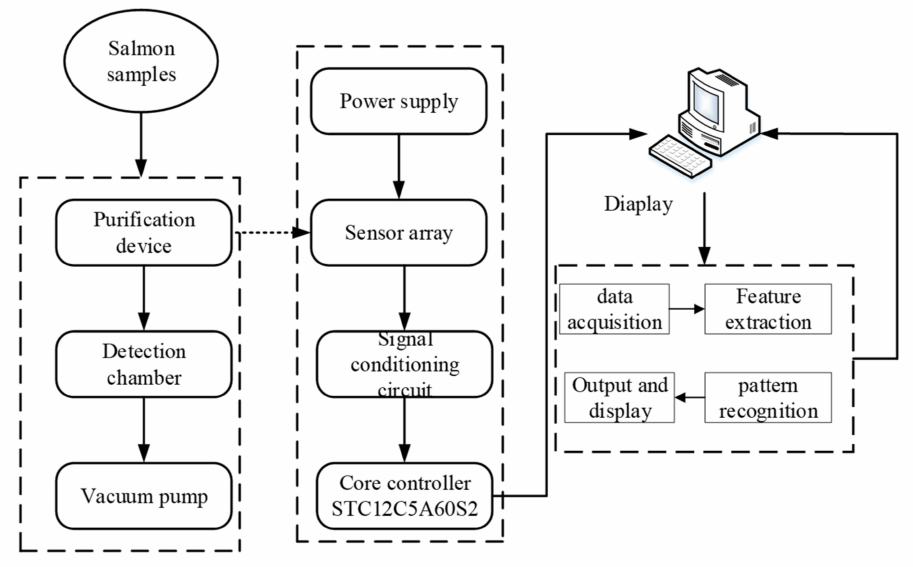
Figure 3. Block diagram of electronic nose detection